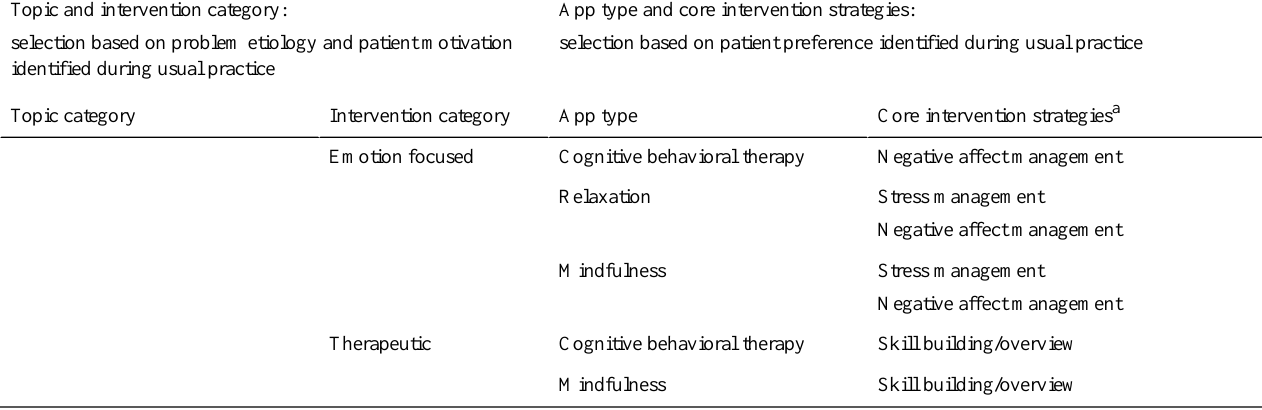
selection based on patient preference identified during usual